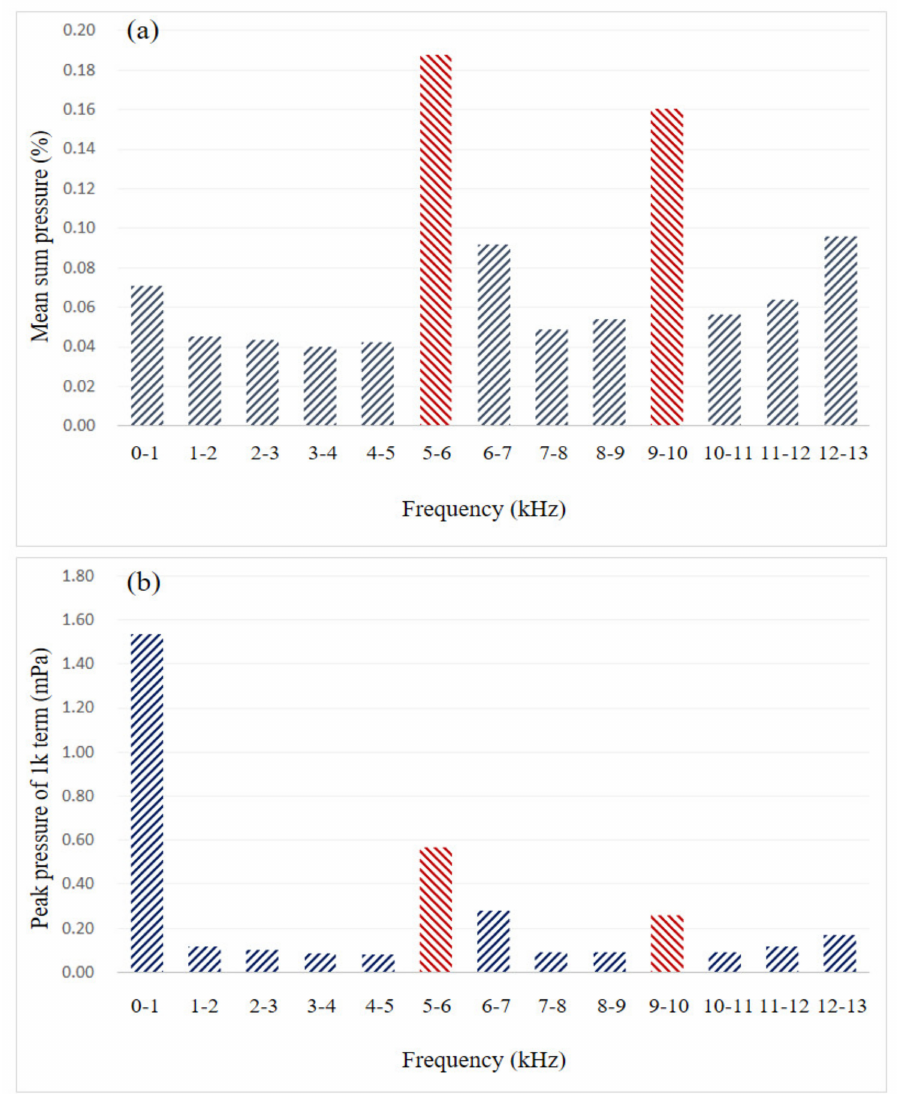
Figure 13. Sound pressure in 1-kHz increments with 9.53-mm particles. ( a ) Mean sum; ( b ) peak